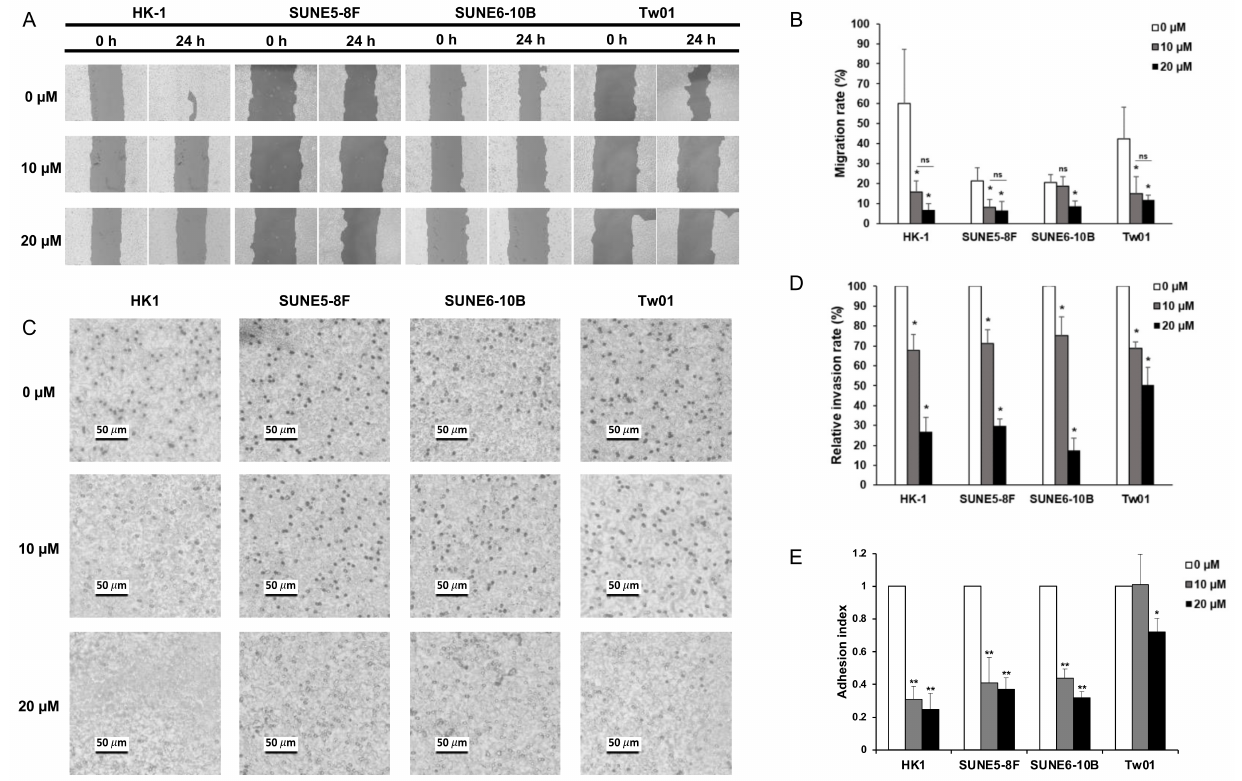
Figure 2. Baicalein inhibits NPC cell migration, invasion, and adhesion. ( A ) Wound-healing assay. NPC cells were seeded and cultured until confluence on the culture plate, and the wound was created by cell scratching for cell migration assay. Then, the cells were treated with 0, 10, and 20 µ M of baicalein. The wound areas were observed at 0 h and 24 h with × 100 magnification using a light microscope, (Eclipse TS100; Nikon Corporation, Minato-ku, Tokyo, Japan), and ( B ) migration rates were represented. ( C ) In vitro invasion assay. The 8-well insert membrane was pre-coated by Matrigel before plating NPC cells. At 24 h, the invasive cells at the lower side of the insert membrane were fixed and stained with crystal violet. The images displayed the number of invasive cells at × 100 magnification using light microscope. ( D ) The invasive rate of NPC cells upon the exposure of different baicalein concentrations was determined by the ratio between the number of invasive cells in baicalein and those in the control groups. ( E ) Cell adhesion assay. NPC cells were resuspended with various concentrations of baicalein (0, 10, and 20 µ M) and incubated for 6 h, then transferred to Matrigel-coated culture plate and cultured for 12 h. The cells re-adhering onto the ECM substrate were determined compared with the non-treated control cells. Data represent the mean ± standard error of the mean (SEM) from three independent experiments, ** p < 0.01 and * p <